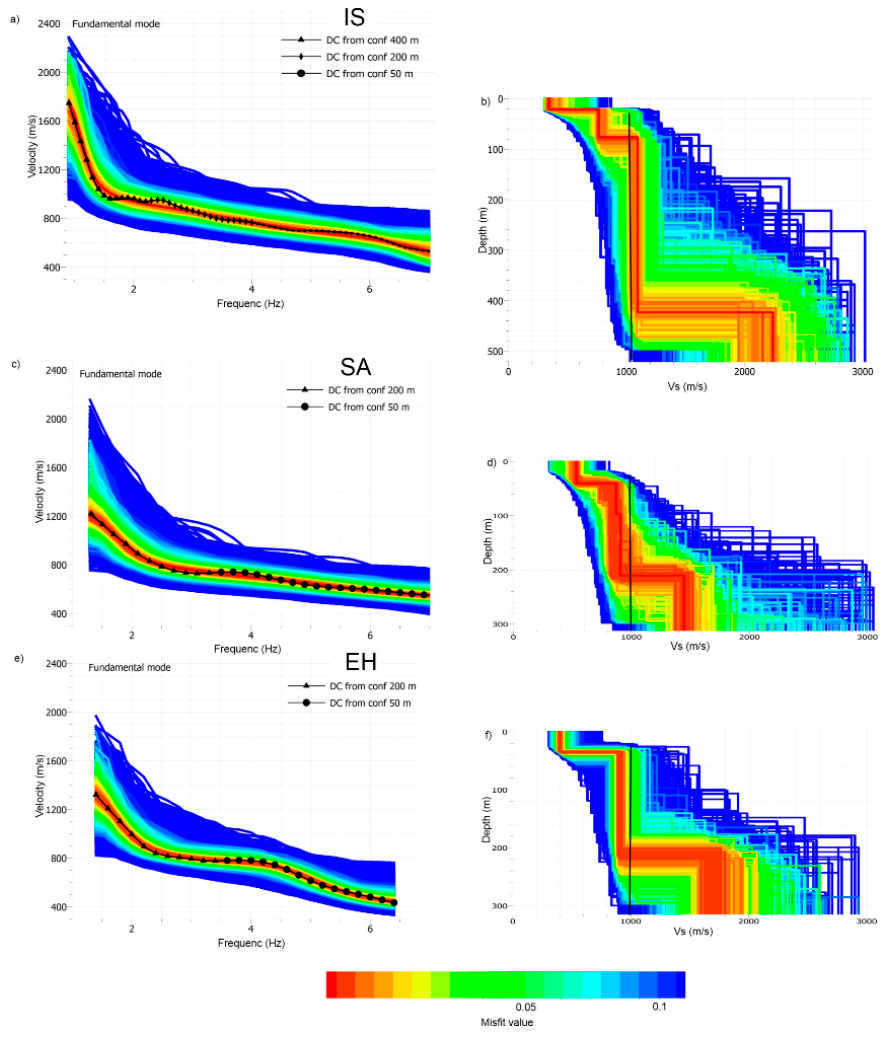
Figure 5. Phase velocity dispersion curves ( a , c , e ) and the derived shear wave velocity structures ( b , d , f ) obtained by the inversion of vertical component ambient noise arrays installed at the IS, SA, and EH sites (locations are in Figure 2).